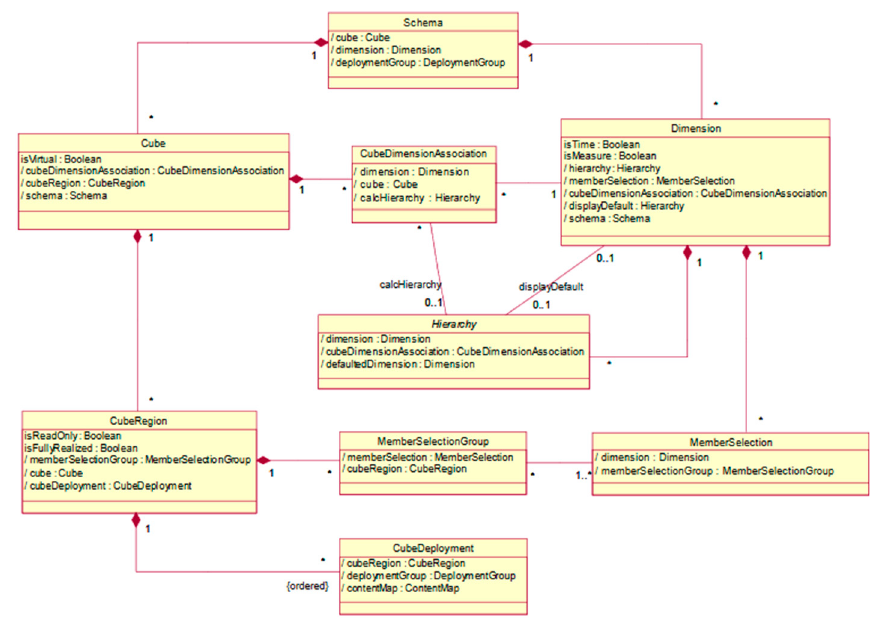
Figure 3. Major classes and associations of Common Warehouse Metamodel (CWM) [49]. Asterisk means “n” according to UML convention.